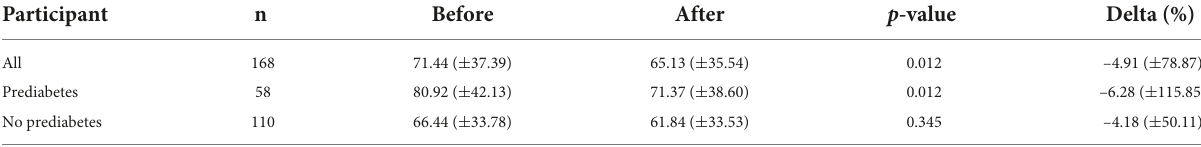
TABLE 4 Comparison of responses to a standardized glucose test meal measured for 120 min determined by iAUC before and after the